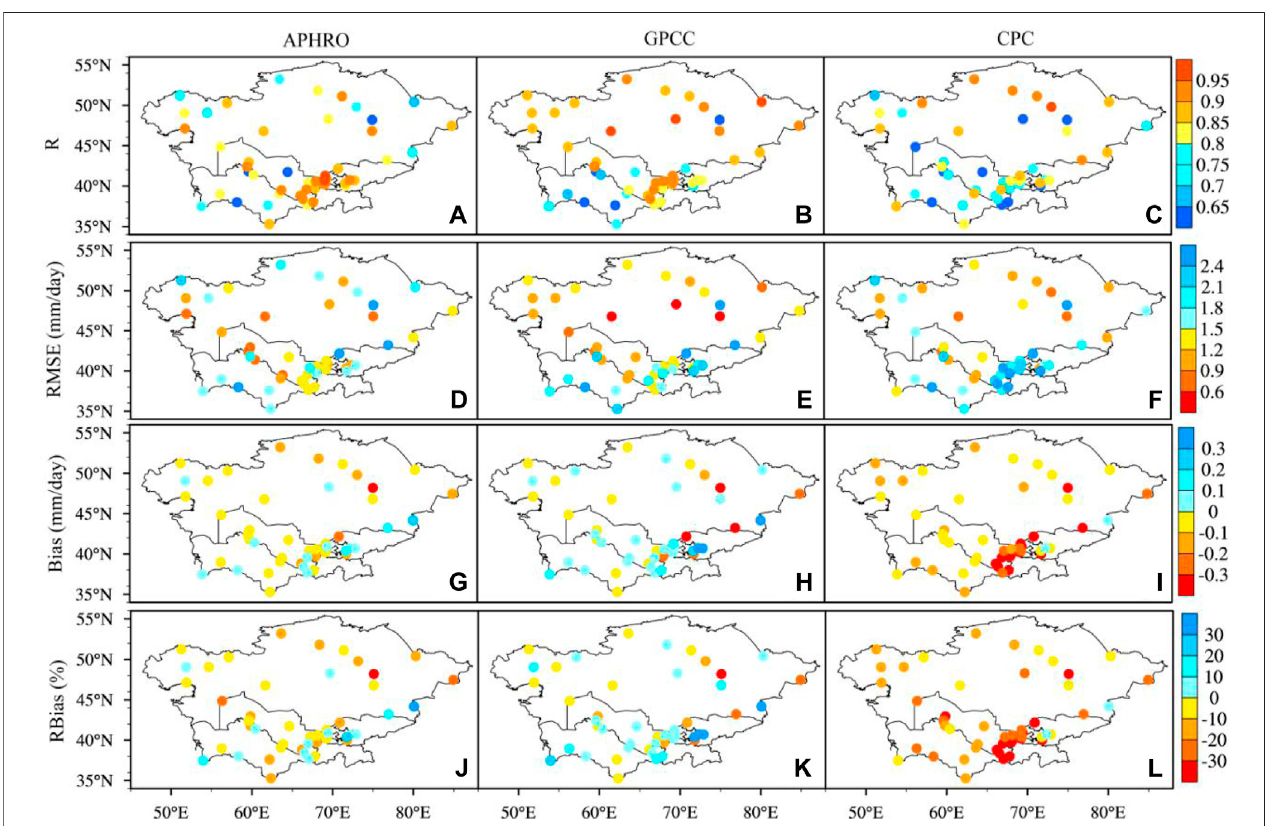
FIGURE5| SpatialdistributionofstatisticalmetricsforthreegriddeddailyprecipitationproductsovertheCAfrom1985to2005.(EachrowisAPHRODITE,GPCC, and CPC. Each column is R, RMSE, Bias, and RBias. (A) , (D) , (G) , and (J) for APHRODITE; (B) , (E) , (H) , and (K) for GPCC; (C) , (F) , (I) , and (L) for CPC).